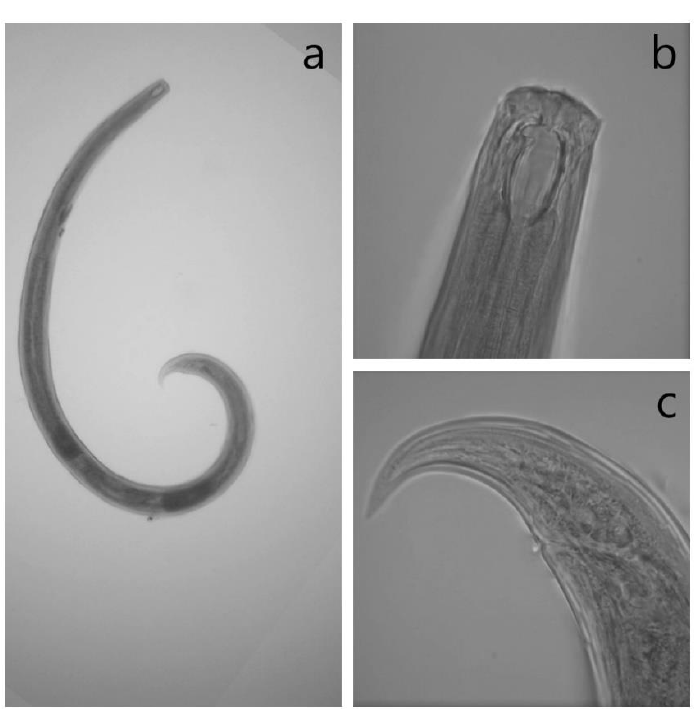
Figure A1. Clarkus papillatus (Bastian, 1865): ( a ) habitus, ( b ) lip region, ( c ) tail; at 200 × magnification: ( a ), at 400 × magnification: ( b , c ) Gödöllő, Hungary.